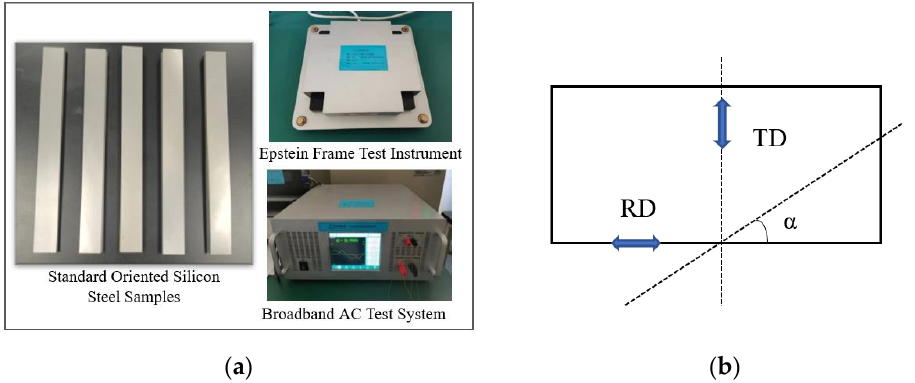
Figure 2. Test equipment and samples. ( a ) Overall schematic diagram of Epstein magnetic measure- ment system; ( b ) shearing of grain-oriented silicon steel sheet.